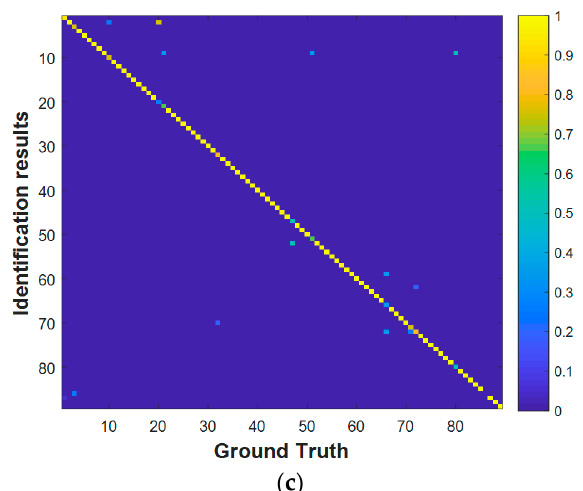
Figure 10. Confusion matrices for signal identification. ( a ) MIT-BIH database; ( b ) ECG-ID database (Two-recording); ( c ) ECG-ID database (All-recording).